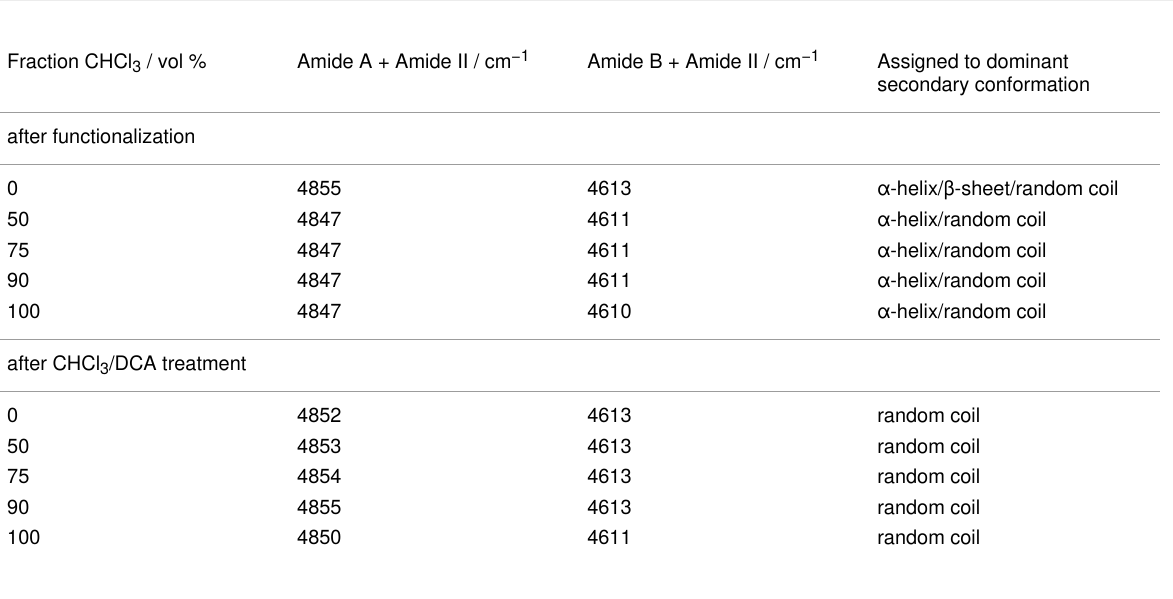
Fraction CHCl 3 / vol % Amide A + Amide II / cm − 1 Amide B + Amide II / cm −